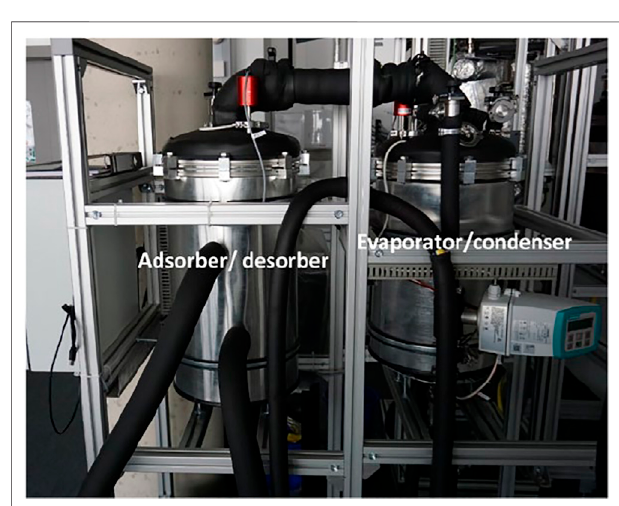
FIGURE 3 | Realized test setup for investigating the APHE at the LSP of OTH-Regensburg, Germany.